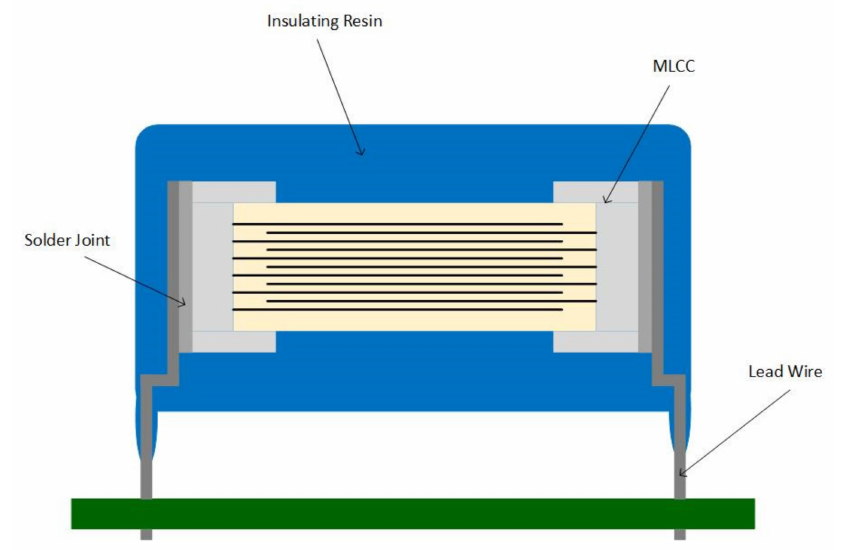
Figure 9. Dipped Radial Leads Capacitor.